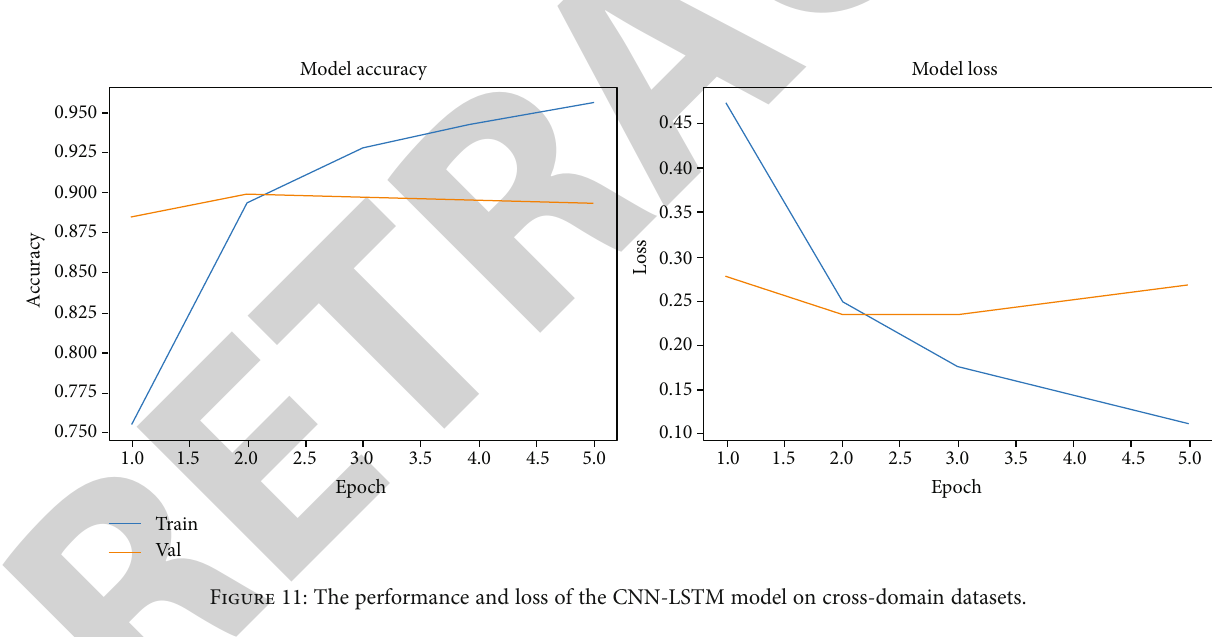
Figure 10: Visualization of the classi fi cation results for cross-domain experiment.